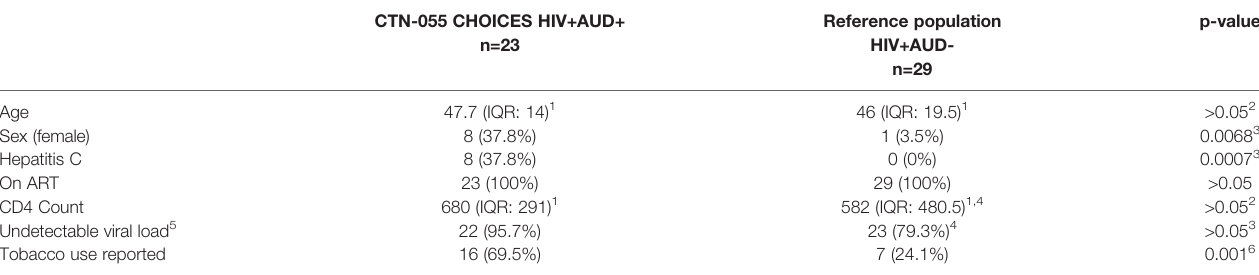
TABLE 1 | Participant demographic and clinical